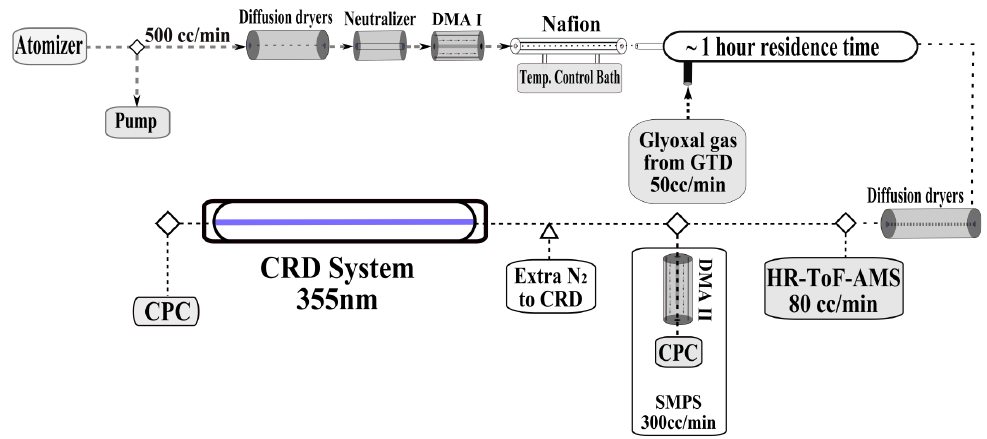
Fig. 1. The experimental setup for the heterogeneous reaction experiments of AS particles with glyoxal.